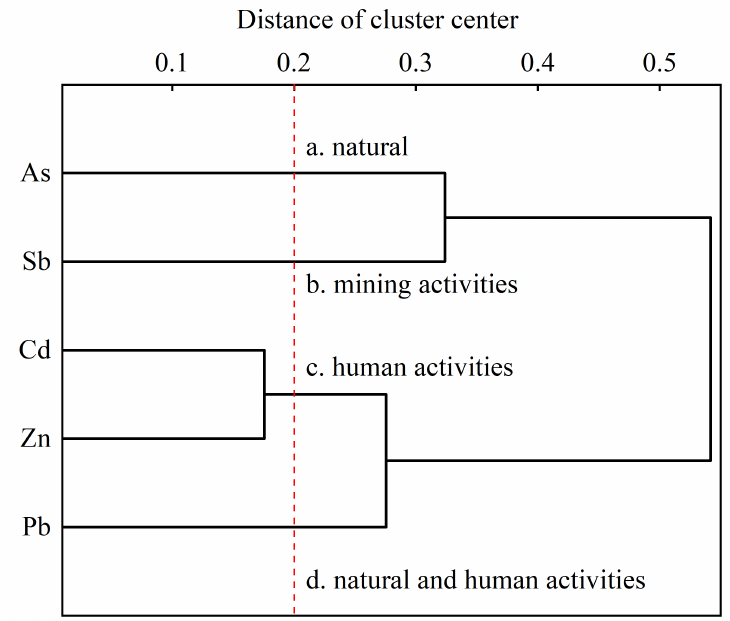
Figure 8. The sources of soil heavy metals and metalloids, indicated by cluster